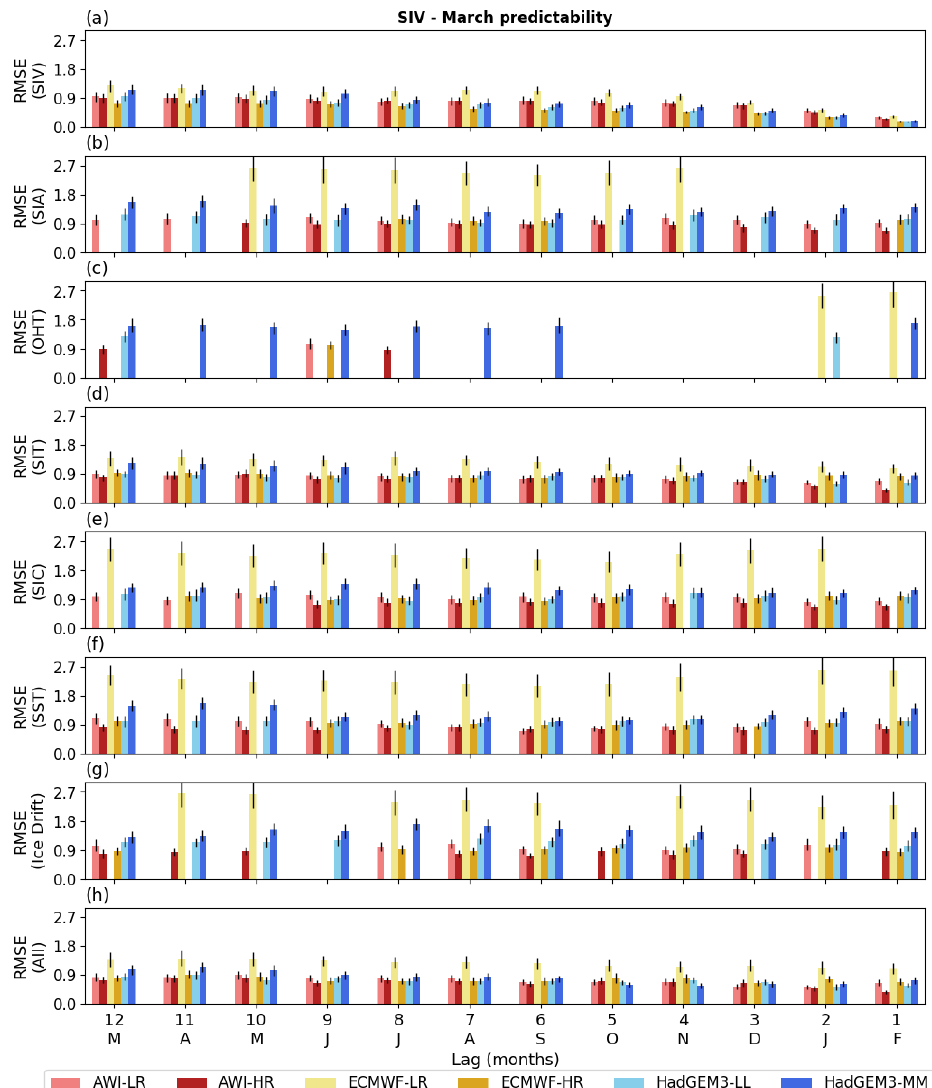
Figure 4. Statistical predictability of the March SIV anomalies, estimated from 12 leading months and quantified by the RMSE (10 3 km 3 ) calculated between the original and reconstructed time series (Sc), as prescribed by seven predictors: (a) SIV itself, (b) SIA, (c) OHT, (d) SIT, (e) SIC, (f) SST, (g) Drift. The predictions employing all predictor variables (except the SIV itself) are displayed in (h) . The vertical black lines indicate the error as provided by the 500 Monte Carlo simulations. The statistical predictability follows the methodology introduced in Sect. 2.3. Missing vertical bars mean that the statistical reconstruction is not statistically significant. The long-term trend and seasonal cycle are excluded from both predictand and